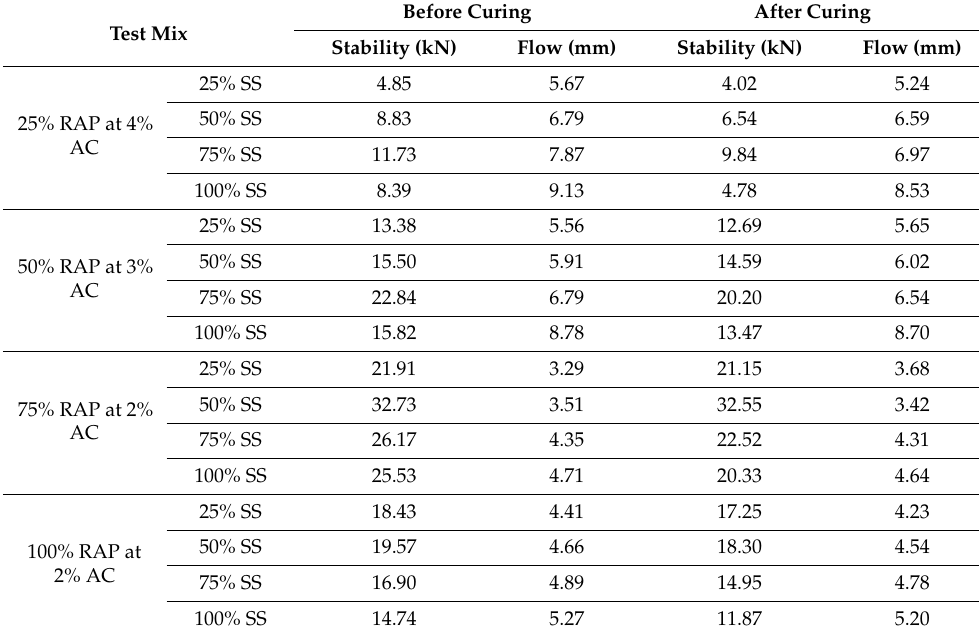
Table 6. Test results for the tested mixes with steel slag under water for 4 days at 50 ◦ C.